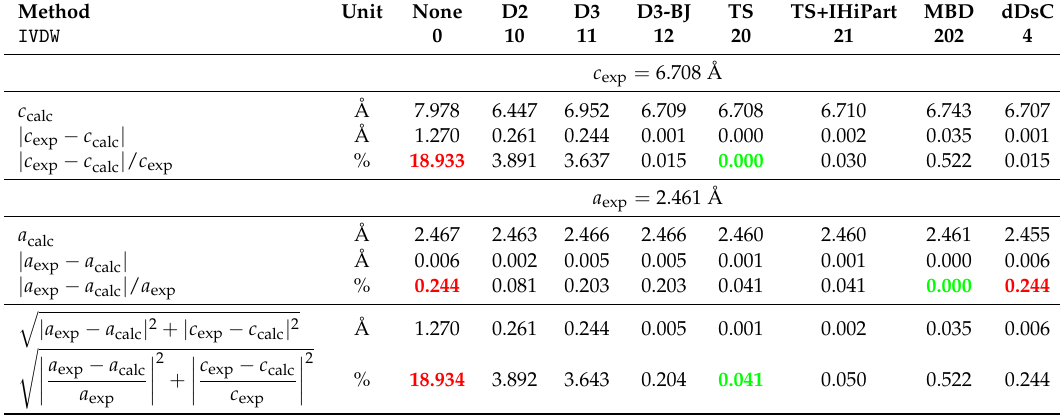
Table A1. Benchmark study of different van-der-Waals corrections implemented in VASP in order to reproduce the experimental lattice parameters of graphite. (D2 = DFT-D2, D3 = DFT-D3, D3-BJ = DFT-D3 with Becke-Jonson (rational) damping, TS = Tkatchenko-Scheffler method, TS+IHiPart = Tkatchenko-Scheffler method with iterative Hirshfeld partitioning, MBD=Many-body dispersion